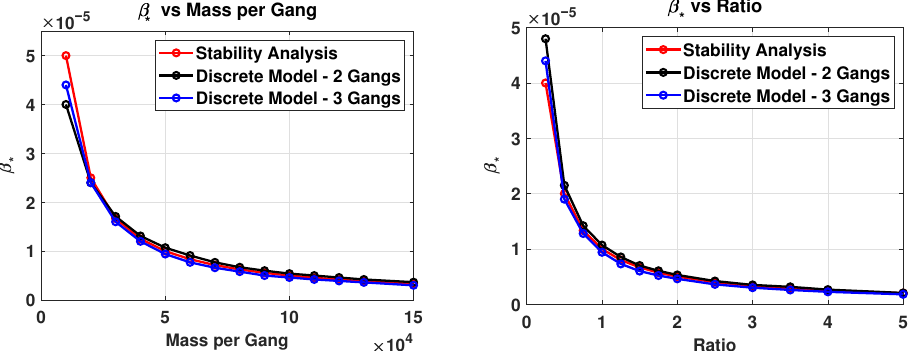
Figure 9. Critical β against the total preserved system mass and γ three gangs. Here, we have δ t = 1 and L = 100. ( Left ) Critical β against the mass when the ratio γ = 1 for both 2 and 3 gangs. ( Right ) Critical β against the γ λ the total mass of the system is preserved to 150,000. We see that increasing the number of gangs from 2 to 3 makes the critical β and the phase transition larger.